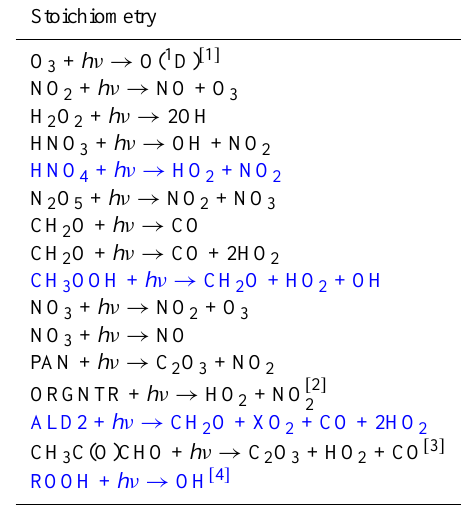
Table 4. The photolysis reactions included in the model. Only shown are the reaction products that are calculated explicitly by the chemical solver. Additional details: [1] The quantum yield for the production of O( 1 D) from the photolysis of O 3 is taken from Shet- ter et al. (1996); [2] For the photolysis rate of ORGNTR, absorp- tion cross section values for a C4 mono-nitrate are used (Roberts and Fayer, 1989); [3] J(CH 3 C(O)CHO) = 5.5* J(CH 2 O → CO + 2HO 2 ) ; [4] The photolysis rate for ROOH is set equal to that of CH 3 OOH due to the lack of data regarding the characteristic ab- sorption parameters. Those photolysis rates which are temperature independent are shown in